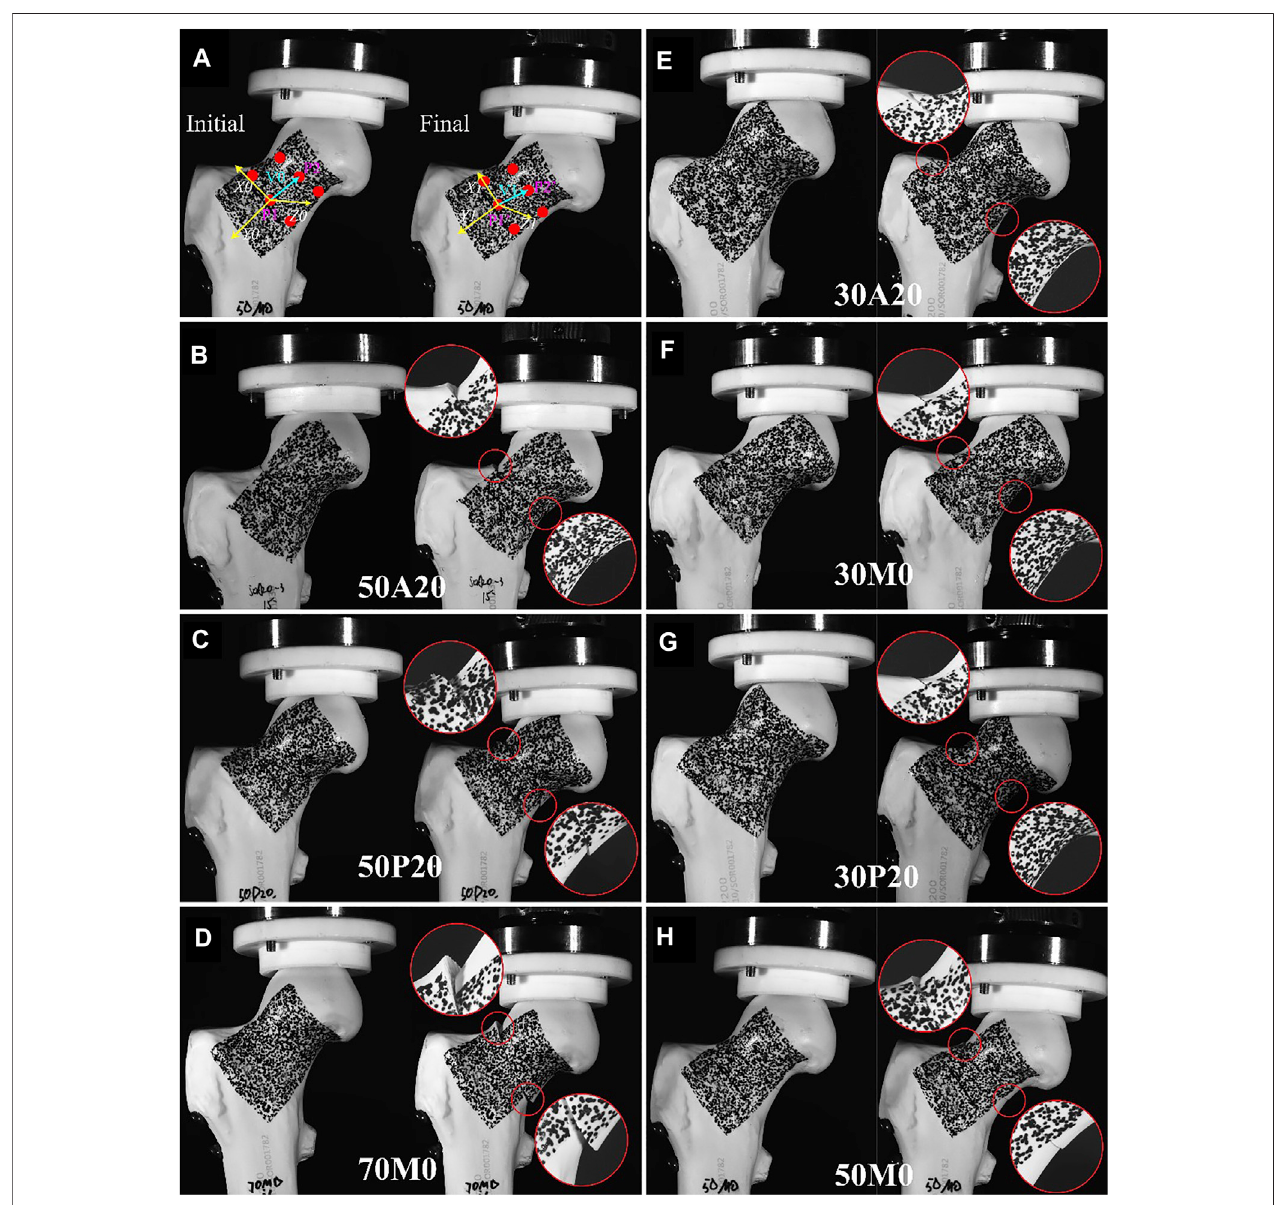
FIGURE4| Validationof3-D unstable inclination anglesinabiomechanical test. Illustratingthecalculationand results ofinterfragmentarymotion. Interfragmentary motion (IFM) was calculated according to the location of the three paired points (red dotted) in proximal and distal fragments, and the local coordinate system (A) . According to the photograph obtained with the VIC-3D, IFM was more severe in unstable groups (B – D) compared to stable groups (E – H) .